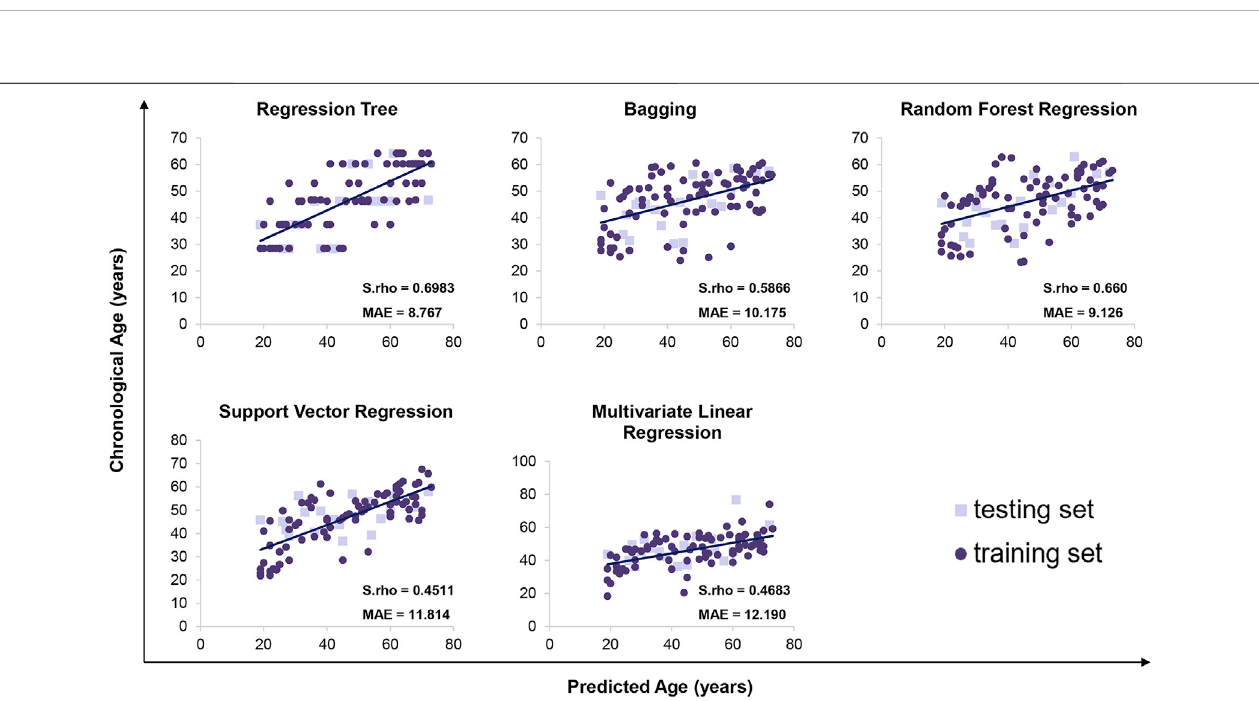
FIGURE 4 | Predicted versus chronological ages using regression tree, bagging, random forest regression, support vector regression, and multivariate linear regression.